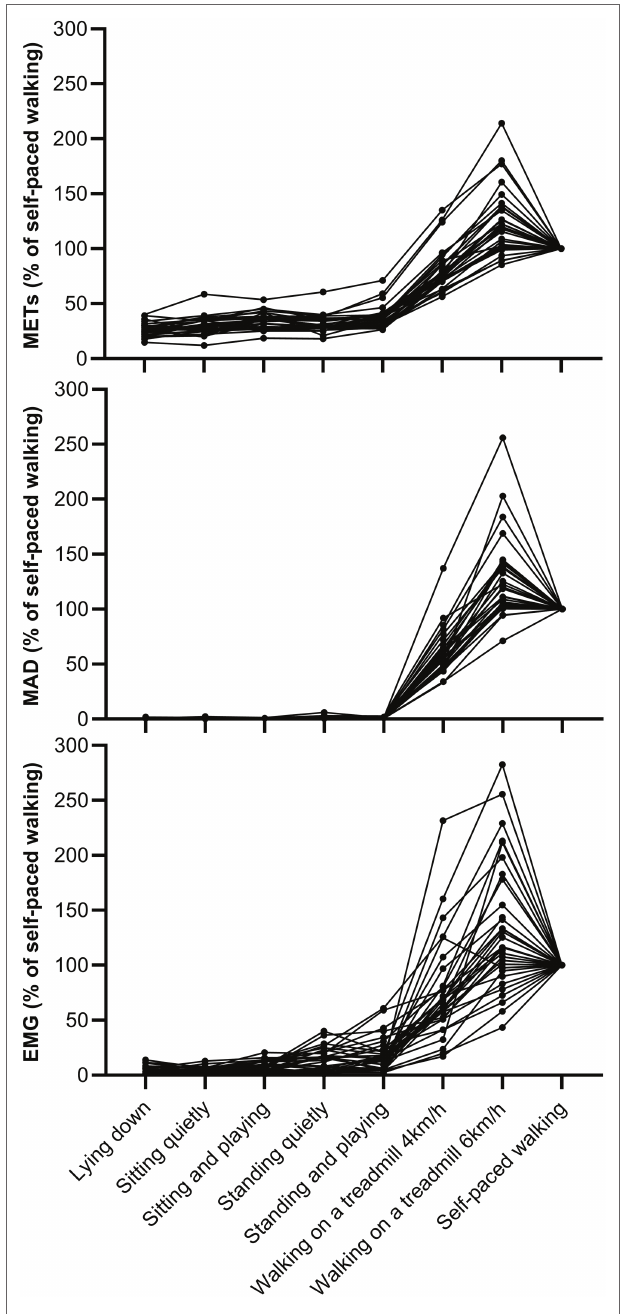
FIGURE 1 | Individual values of METs, MAD, and EMG during different activities normalized for corresponding measure during self-paced walking. Each plot and line correspond to an individual